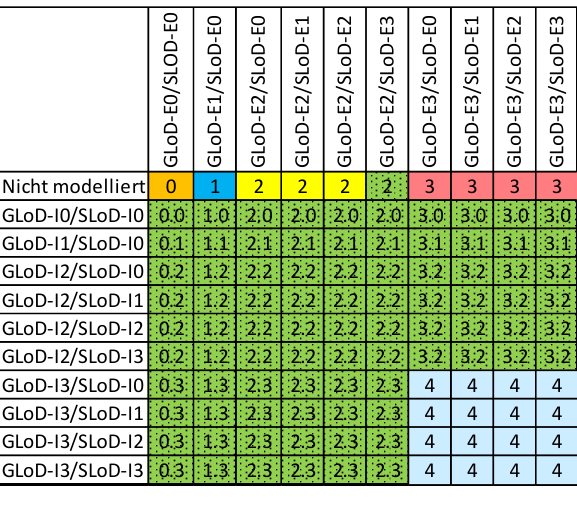
Table 6: Combination of interior and exterior models, qualified by an extension of the CityGML LoD. The colour schema of Table 5 is